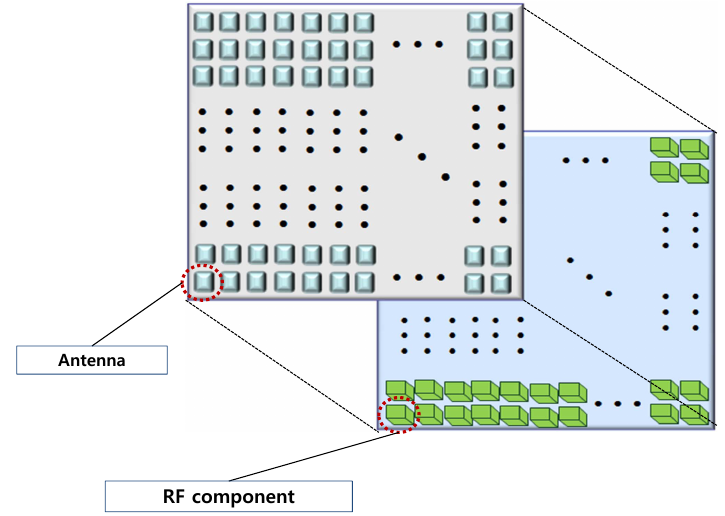
Figure 3. An implementation example of the antenna and RF in an LS-MIMO